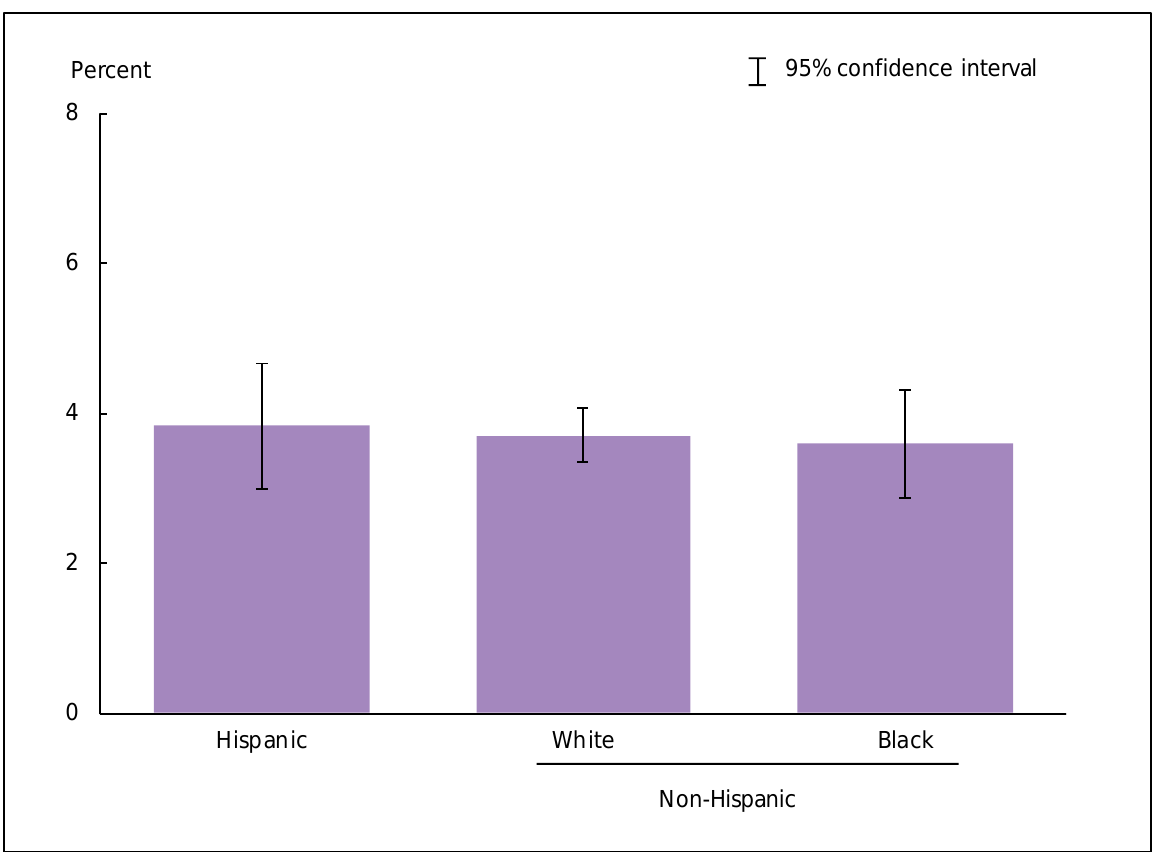
Figure 13.3. Age-sex-adjusted percentage of adults aged 18 and over who experienced serious psychological distress during the past 30 days, by race and ethnicity: United States,